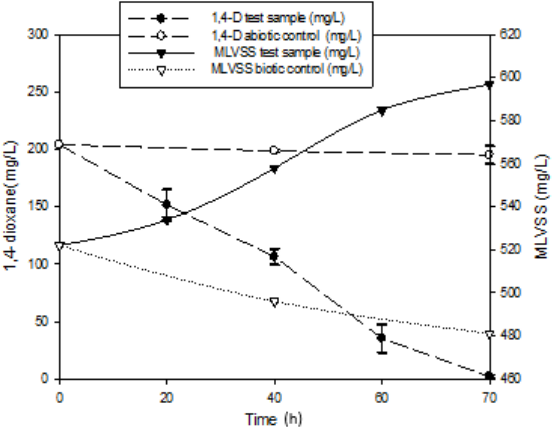
Figure 3. Biodegradation of 1,4-dioxane at 200 mg / L of the initial concentration.